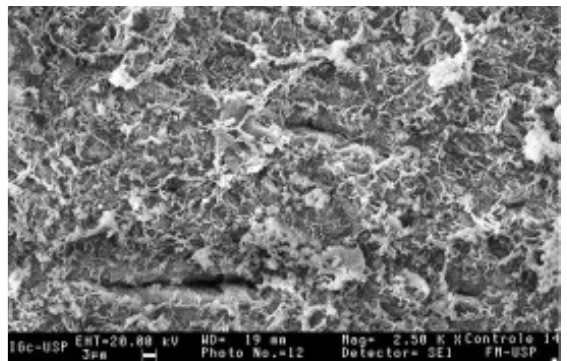
Fig. 4– Microscopia eletrônica de varredura da válvula convencional (GA). Ausência de células endoteliais. Colágeno desnudo